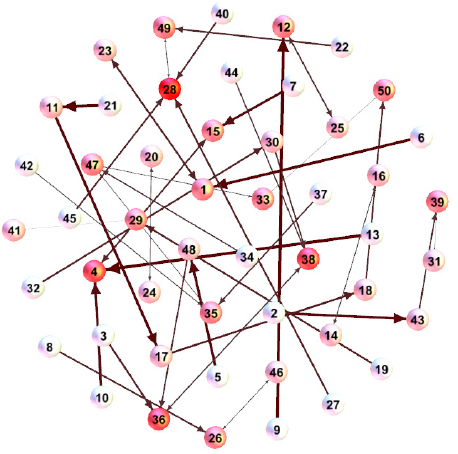
Figure 17. The spatial structure graph for S01 at generation 100.